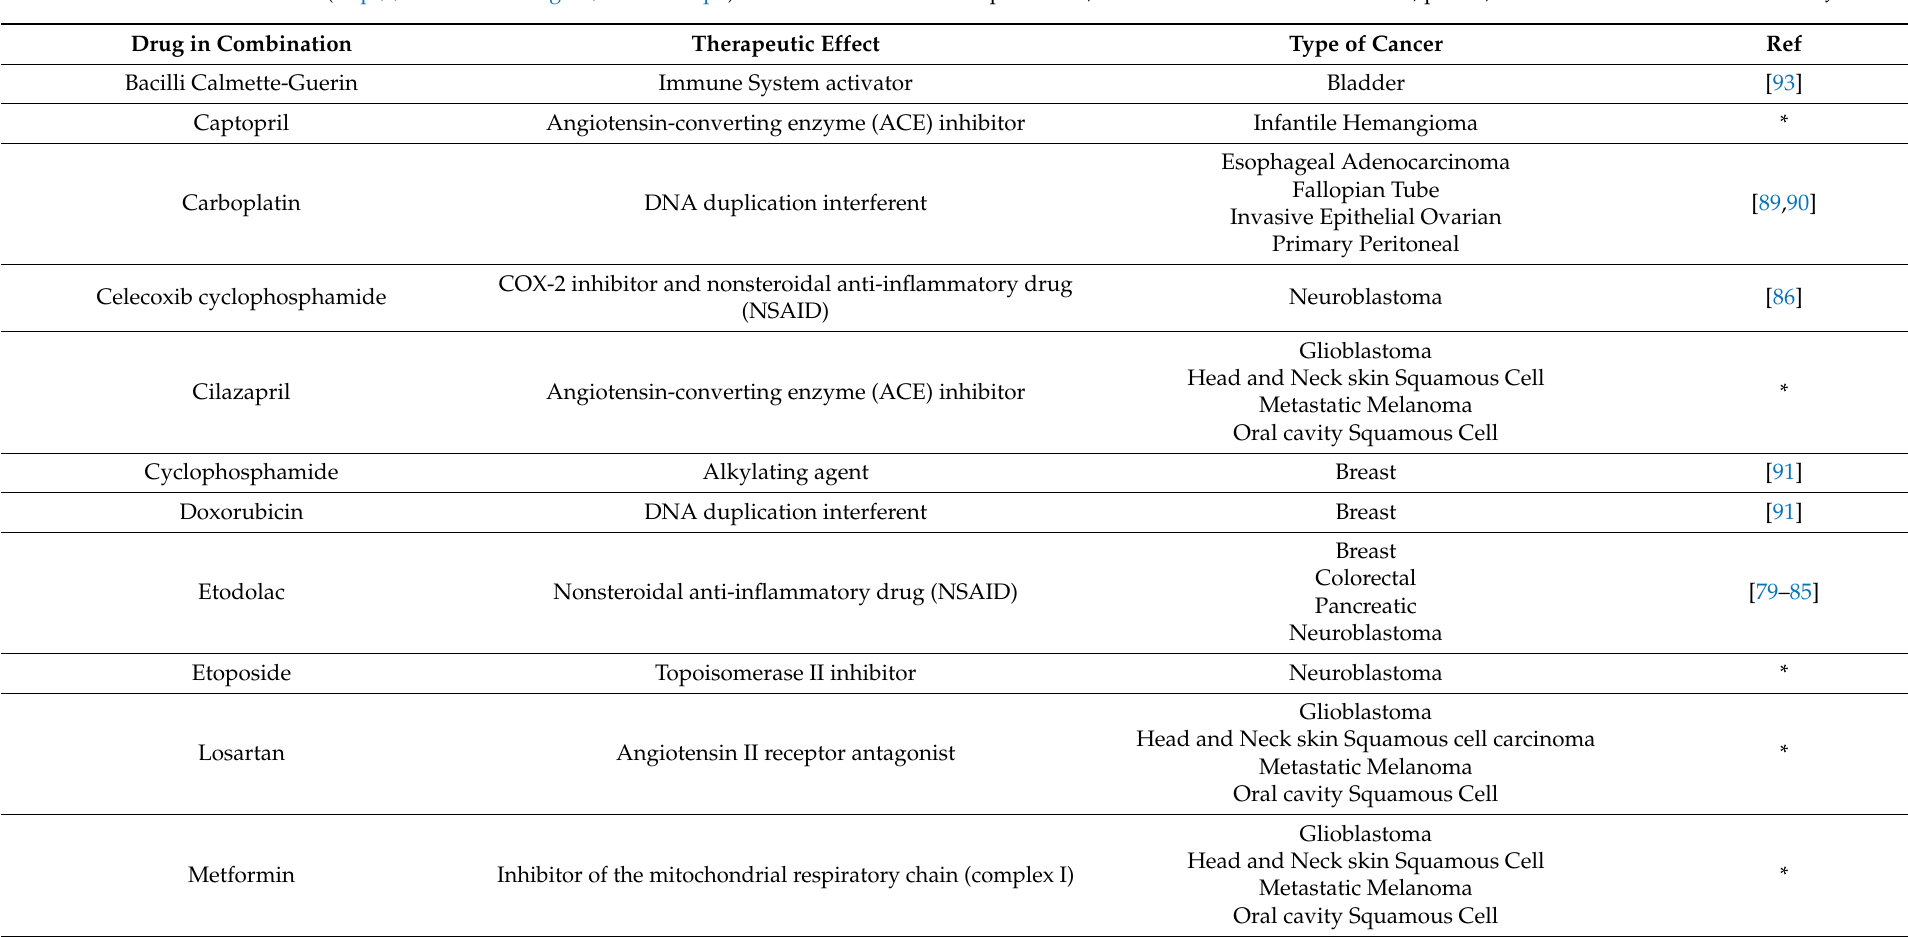
Table 1. Propranolol as adjuvant to different chemotherapeutic drugs used in combination in interventional clinical trials registered at the EU Clinical Trials Register (https://www.clinicaltrialsregister.eu), the U.S. National Library of Medicine (https://clinicaltrials.gov), and the Australian New Zealand Clinical Trials Registry (http://www.anzctr.org.au/Default.aspx). * Studies with no results published, for further details about the trial, please, visit the Table S3. Accessed on 14 June